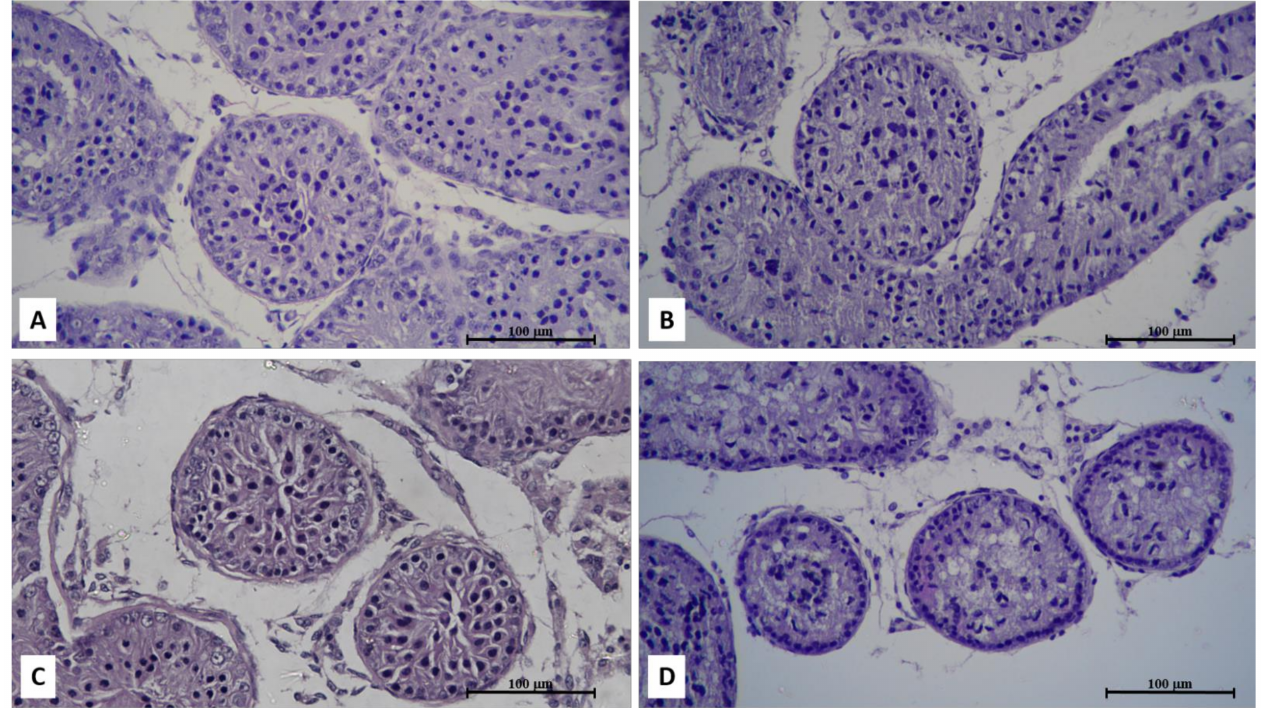
Figure 1. Photomicrograph of prepubertal dog testicular fragments. Note the poorly developed germinal epithelium, with good distinction between spermatogonia and Sertoli cells except in the last group. ( A ) Fresh seminiferous tubules with intact morphology; ( B ) Seminiferous tubules of testicular fragments vitrified with EG/GLY association, showing basement membrane retraction and nuclear visualization similar to the control; ( C ) Seminiferous tubules of testicular fragments vitrified with DMSO/EG association, showing greater separation of the basement membrane compared to the control; ( D ) Seminiferous tubules of testicular fragments vitrified with DMSO/GLY association, showing greater nuclear condensation and poor distinction between spermatogonia and Sertoli cells. H-E, 200 ×